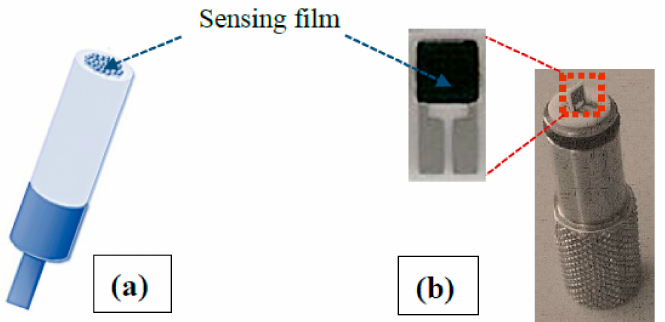
Figure 2. Picture of: ( a ) electrochemical and ( b ) conductometric sensor platforms. HA-GN-MWCNT composite sensing film area are indicated by